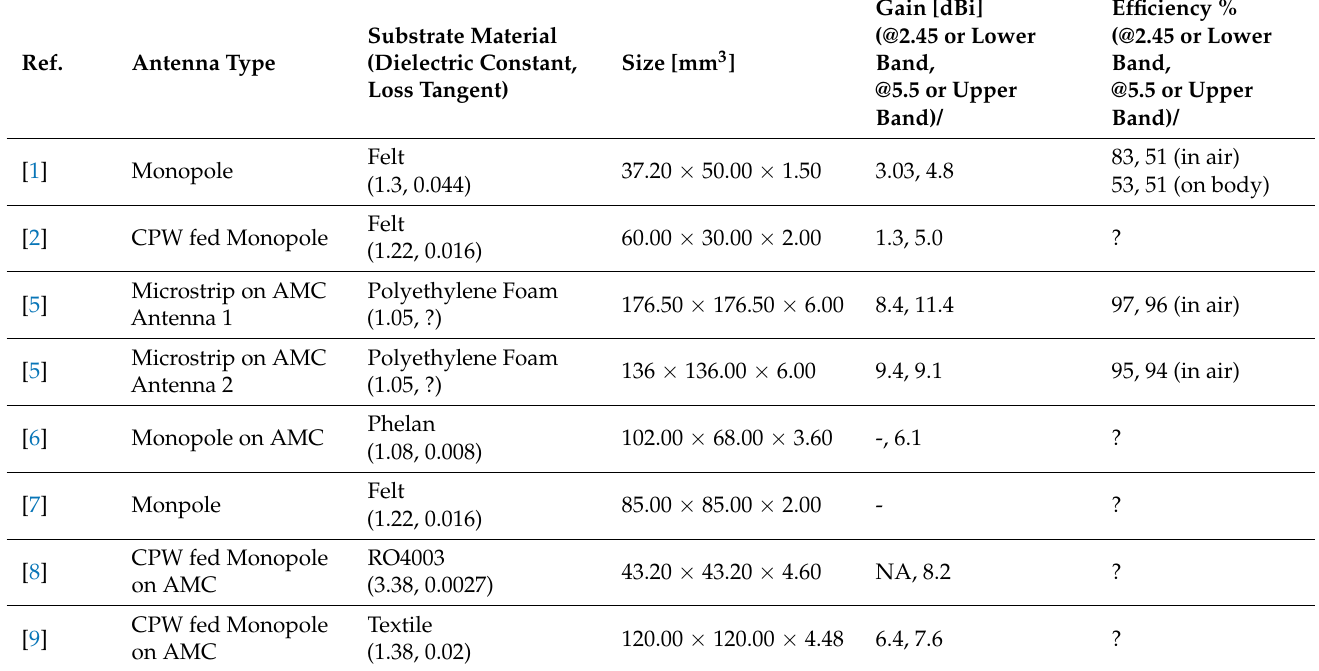
Table 1. Comparing the WiFi wearable antennas proposed in the literature and this paper.